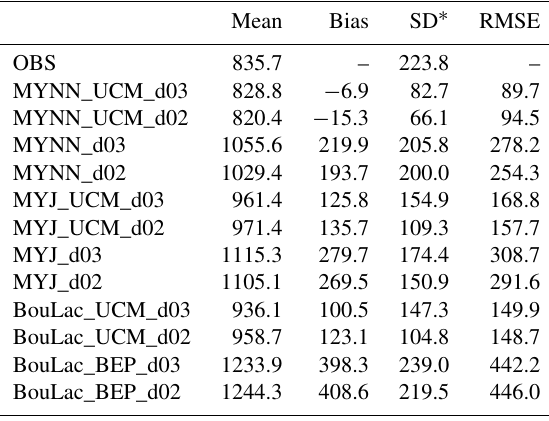
Table 3. Comparison statistics of model performance on PBL height (unit: ma.g.l.) relative to the ceilometer data over 11:00–17:00PST at